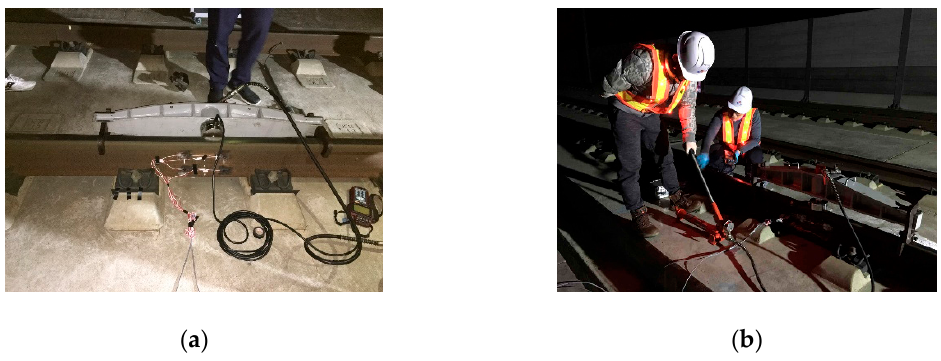
Figure 7. Wheel load calibrator setting and calibrating. ( a ) Calibrator setting; ( b ) Wheel load calibration.